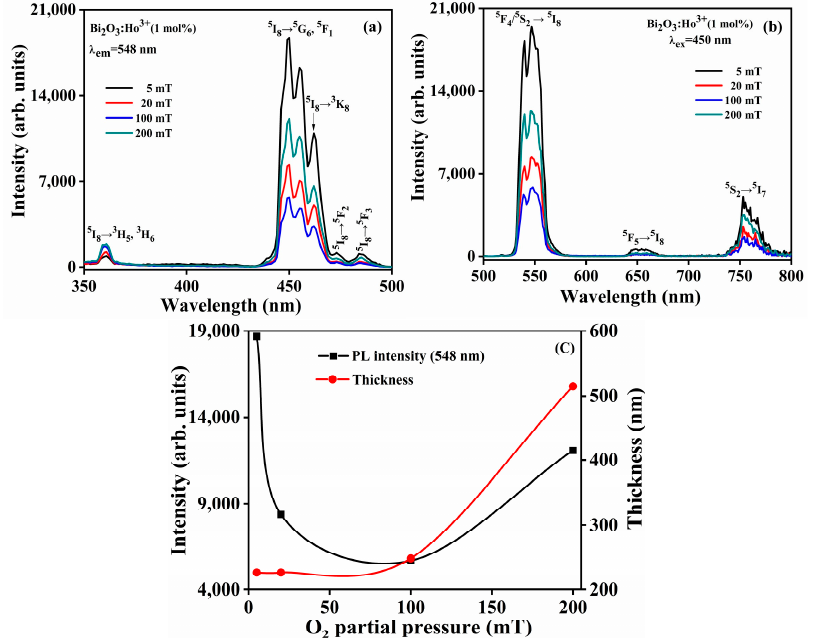
Figure 23. PL spectra of the Bi 2 O 3 :Ho 3+ films: ( a ) excitation and ( b ) emission spectra of the films deposited at oxygen partial pressures of 5, 20, 100 and 200 mT at a substrate temperature of 400 °C. ( c ) The variation in PL emission intensity of the 548 nm peaks and the corresponding thickness for the different O 2 partial pressure.